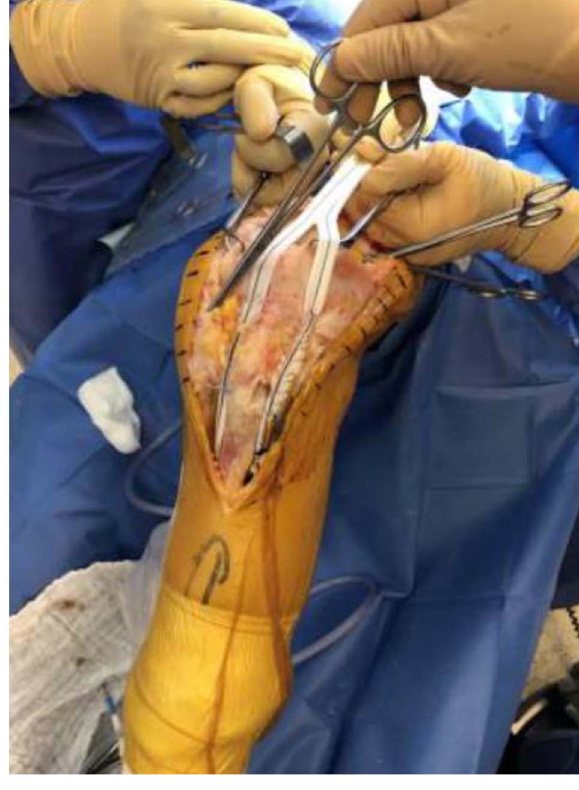
Figure 3. Augmentation of the allograft with the vascular